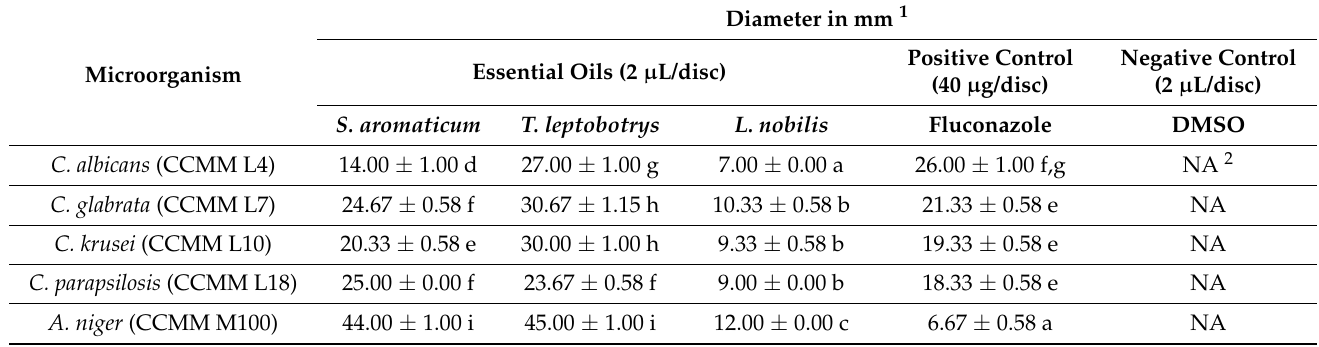
Table 2. Diameter of inhibition zones (mm) of essential oils against fungal